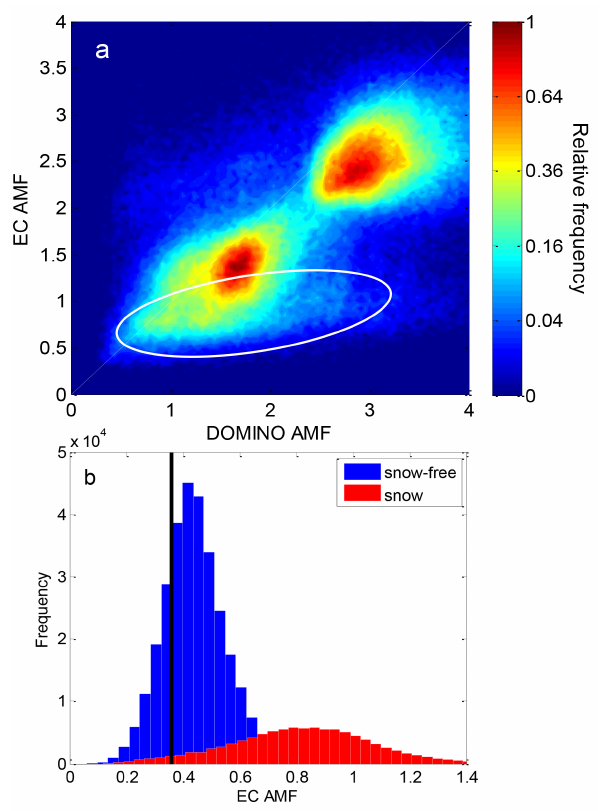
Fig. 6. (a) Scatterplot of DOMINOv2 vs. EC NO 2 AMFs for all OMI observations within 200km of the reference location and cloud radiance fraction of 0.2 or smaller. Note the non-linear scale. The white ellipse shows the AMFs over the surface mines (a small over- all fraction of the points considered here). (b) Histogram of SO 2 AMFs within 200km of the reference location, separated according to snow-covered surface, and snow-free. The black line indicates the constant AMF of 0.36 used in the NASA SO 2